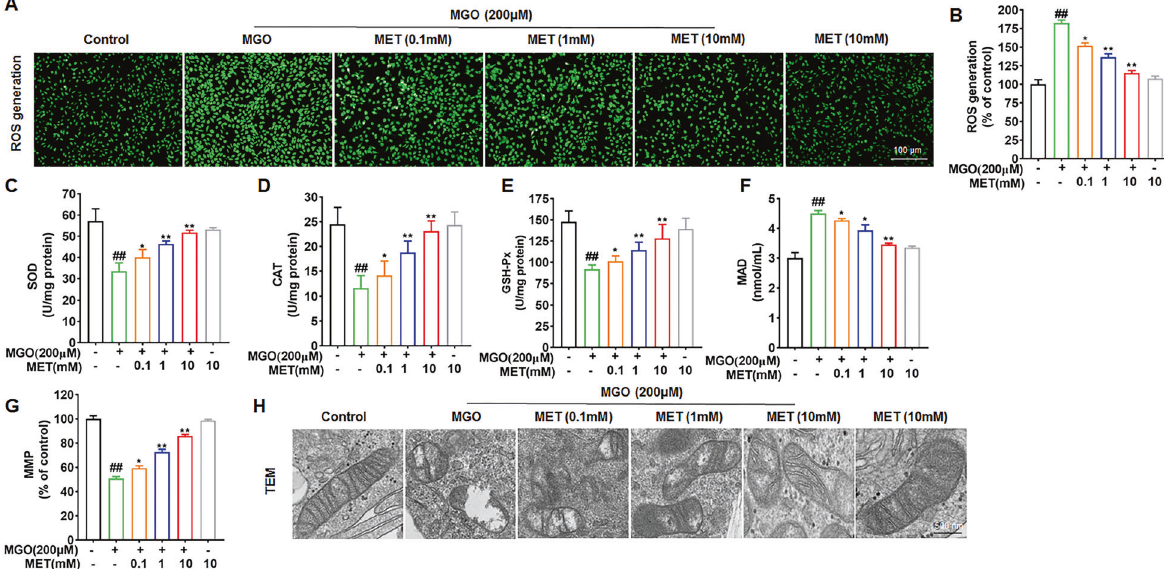
Fig. 2 MET decreases MGO-induced intracellular ROS generation. HUVECs were treated with MET (0, 0.1, 1, and 10 mM) for 2 h and then exposed to MGO (200 μ M) for 1 h. A , B Then, the cells were stained with DCFH-DA, and the fl uorescence intensity was measured at 488/ 525 nm using a microplate reader. Scale bar, 100 μ m. C – F The levels of SOD, CAT, and GSH-Px and the MDA content were measured with the respective ELISA kits. G The MMP was assessed with the JC-1 probe. The fl uorescence intensities of JC-1 monomers (490/530 nm) and JC-1 aggregates (525/590 nm) were measured using a microplate reader. The ratio of JC-1 aggregates/JC-1 monomers was calculated. H Ultrastructural alterations of mitochondria were detected by TEM. Scale bars: 500 nm. All data are shown as the mean ± SD of three independent experiments. ## p < 0.01 vs. Control, * p < 0.05 vs. MGO, ** p < 0.01 vs.